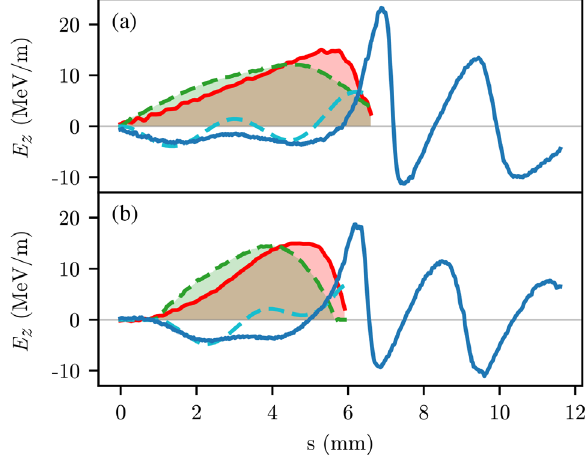
FIG. 3. Wakefield measurement (blue), normalized current reconstruction (red), normalized current profile measurement (green, dashed), and wakefield prediction from current measure- ment (light blue, dashed) from single shot longitudinal phase space measurements of the beam after a plasma accelerator. Measurements from two different beam shapes (a) linear ramp, (b) linear ramp with parabolic head are